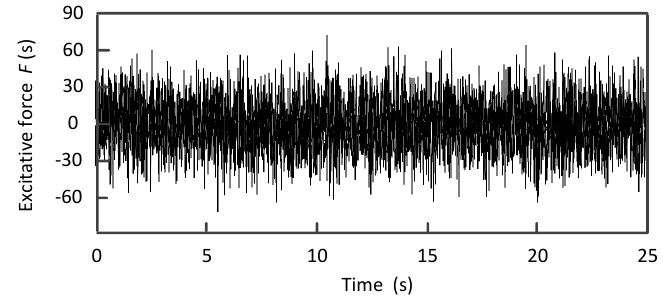
Figure 3. Measured random excitation signal.